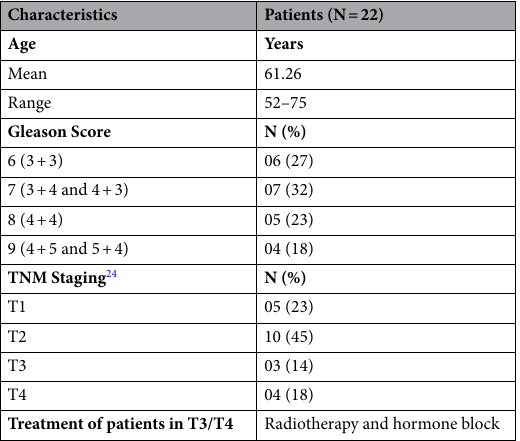
Table 1. Gleason score and tumor TNM staging of prostate cancer